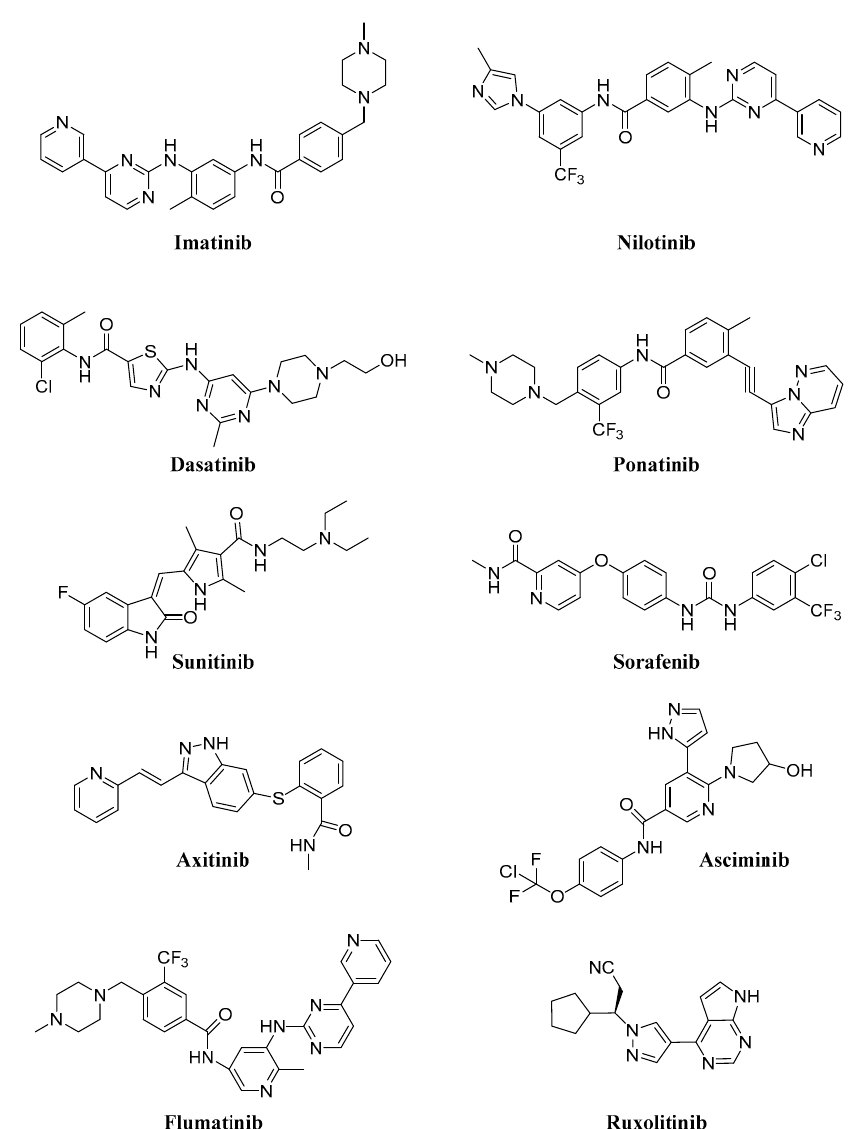
Figure 1. Chemical structure of selected tyrosine kinase inhibitors (TKIs).